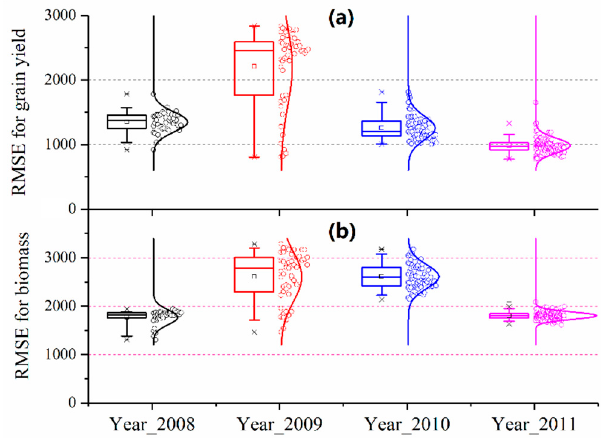
Figure 3. Box plots for RMSEs (Root Mean Square Error, kg ha − 1 ) for simulated grain yield ( a ) and biomass ( b ) across the selected cases within 10% of calibrated minimum Φ values from the 300 cases generated by the Latin hypercube sampling (LHS) for Year_08, Year_09, Year_10, and Year_11. The boxplots show the minimum and maximum (asterisks), medians (lines), and means (dots). The 25% and 75% percentiles are shown as the tops and bottoms of the boxes, and the 5% and 95% percentiles are shown as the whiskers below and above the boxes.